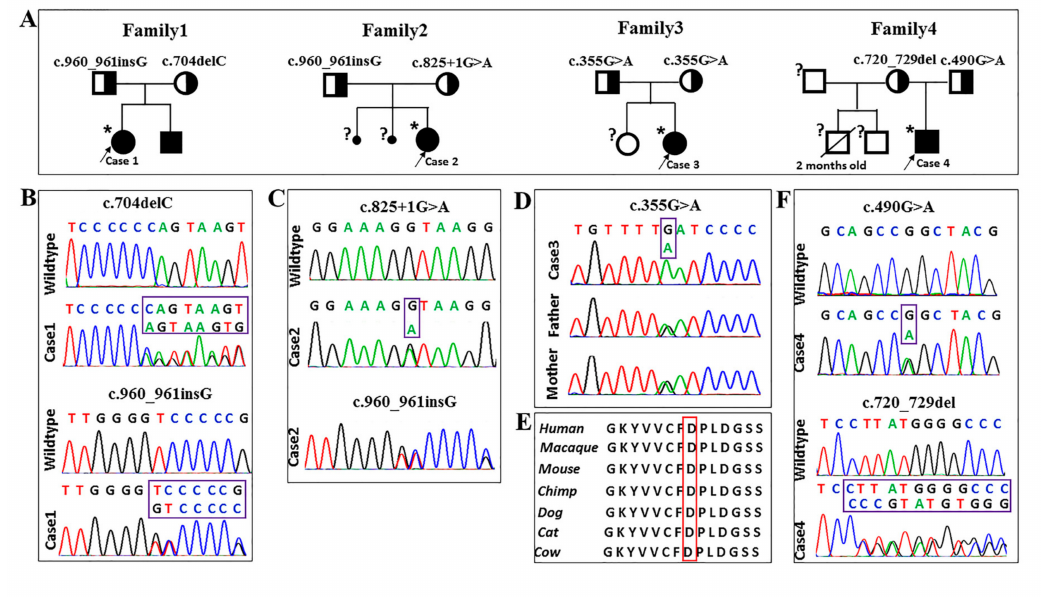
Figure 3. Pedigrees of the families and genetic sequencing findings. ( A ) The pedigrees of all investigated cases. Asterisks (*) indicate individuals subjected to next-generation sequencing, individuals marked with a question mark (?) were not genotyped for the FBP1 variants. ( B – D , F ) Variants in FBP1 gene identified by NGS were verified by Sanger sequencing. Three small deletions/duplications (c.704delC, c.960_961insG, and c.720_729del), two missense (c.355G>A and c.490G>A), and one